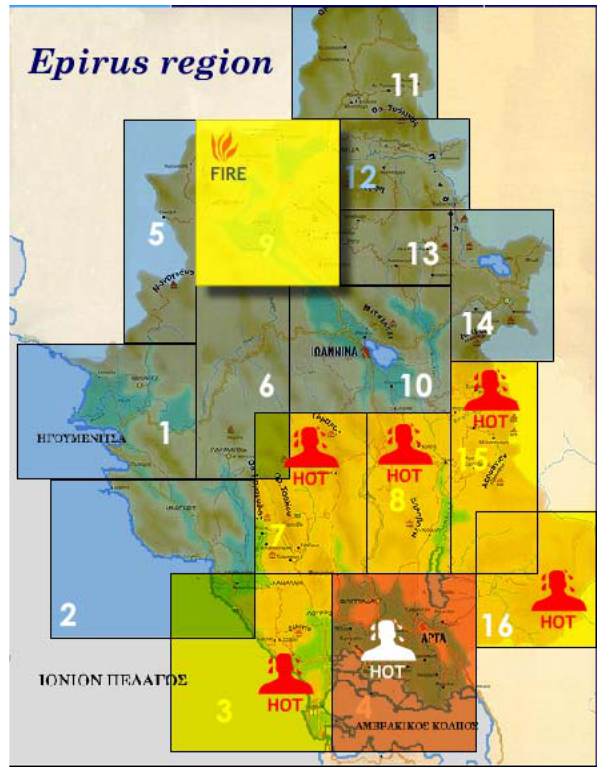
Fig. 4. A summer example of human discomfort and fire weather alerts for Epirus.